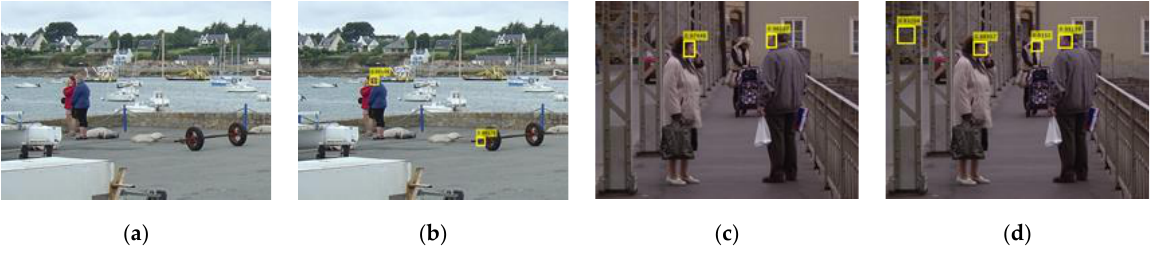
Figure 6. Compare to the results obtained with the complete MTCNN detector ( a , c ), more true faces are detected ( b , d ) when the O-Net is removed.